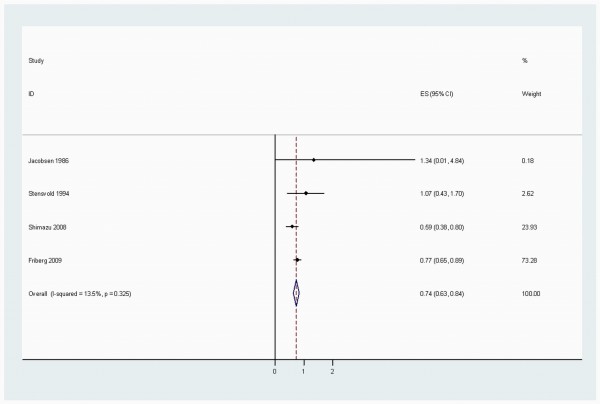
Summary RRs of endometrial cancer for high coffee drinkers versus non/lowest drinkers from included studies. Squares represent study-specific relative risk estimates (size of the square reflects the study-specific statistical weight, that is, the inverse of the variance); horizontal lines represent 95% CIs; diamonds represent summary relative risk estimates with corresponding 95% CIs.